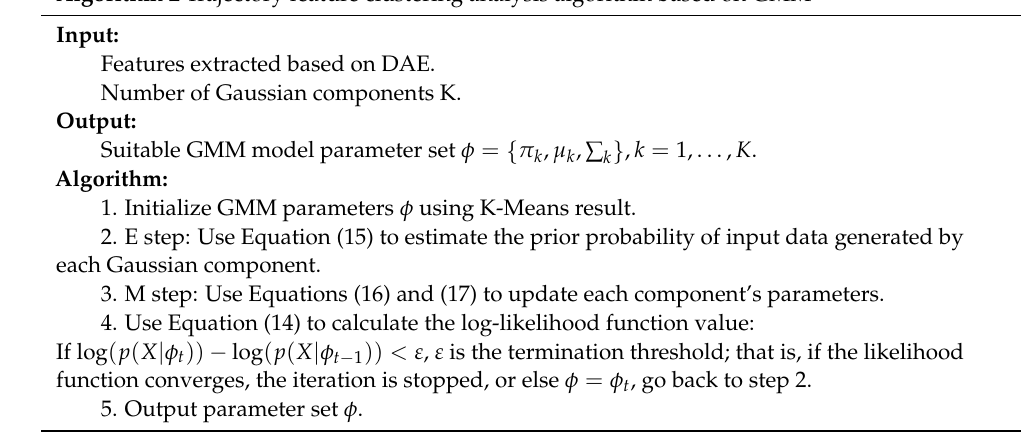
Algorithm 2 Trajectory feature clustering analysis algorithm based on